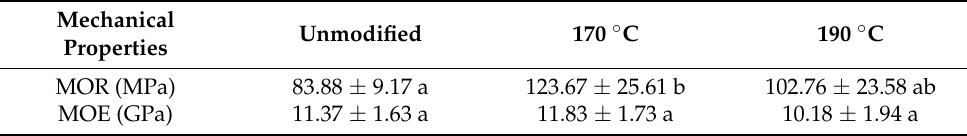
Table 4. Static bending of thermally modified Pinus oocarpa